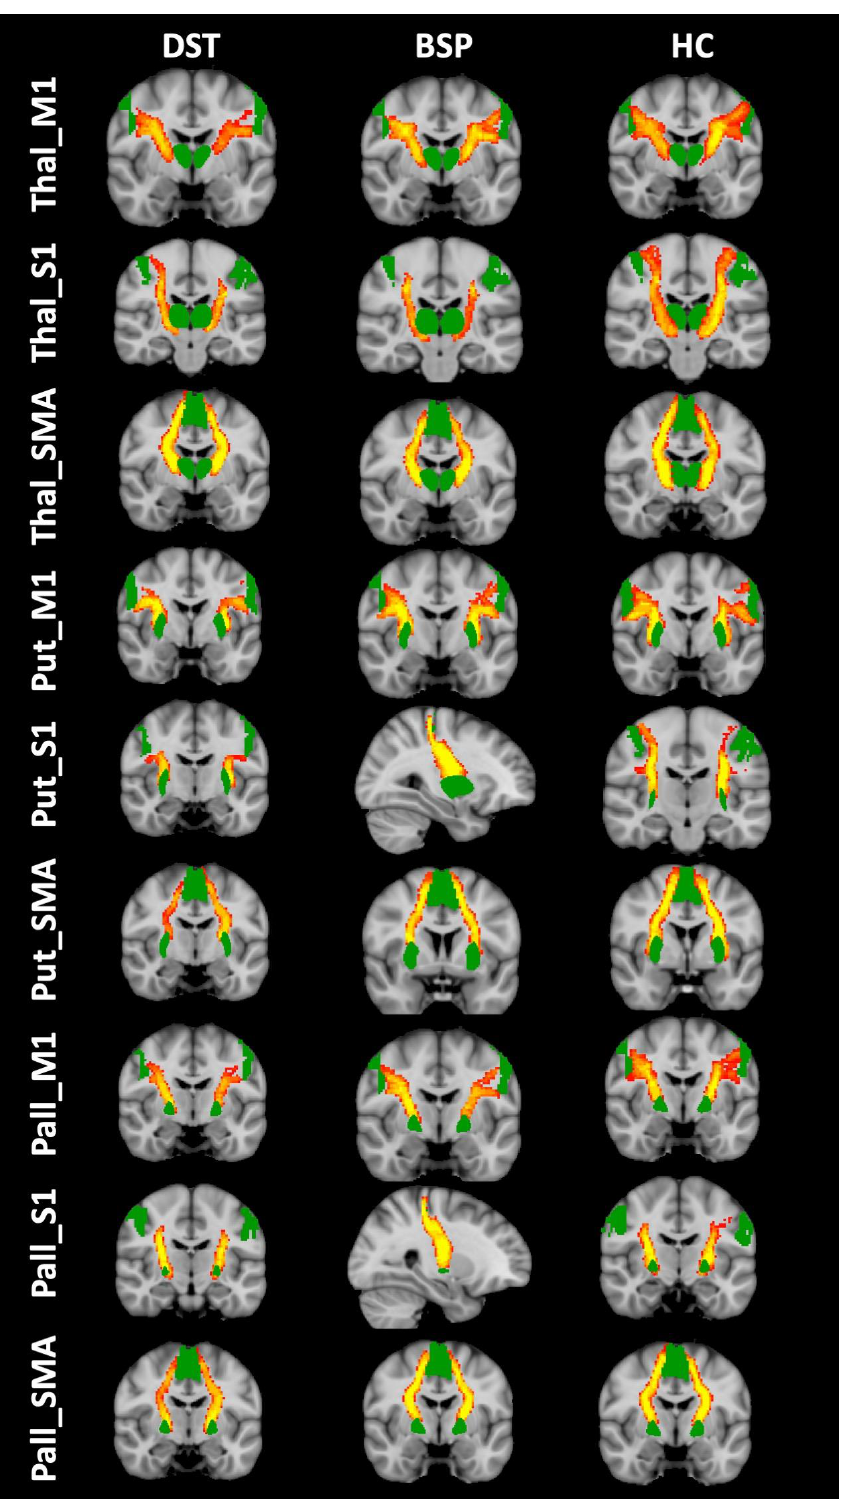
Figure 1. Reconstructed white matter tracts in healthy subjects (HC) (( right ) DST patients ( left ) and BSP patients ( center ) overlaid on the MNI152 standard brain). Red-yellow colors mean the extent of spatial overlap of reconstructed tracts between participants; specifically, red indicates at least 50% overlap and yellow indicates 100%. Green areas are the regions of interest used for probabilistic tractography.